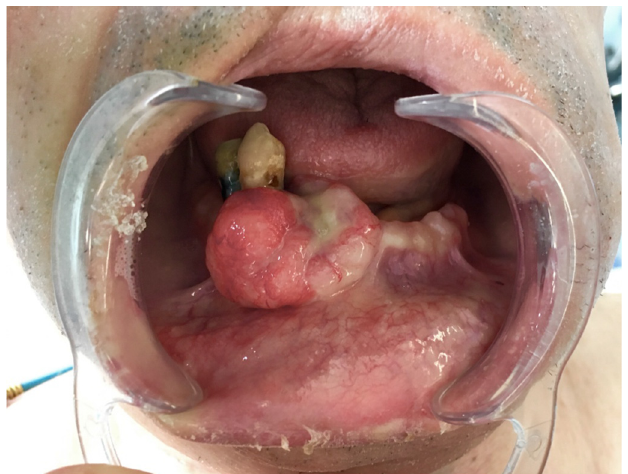
Fig. 1. A burgeoning painful and ulcerated mandibular intraoral lesion.